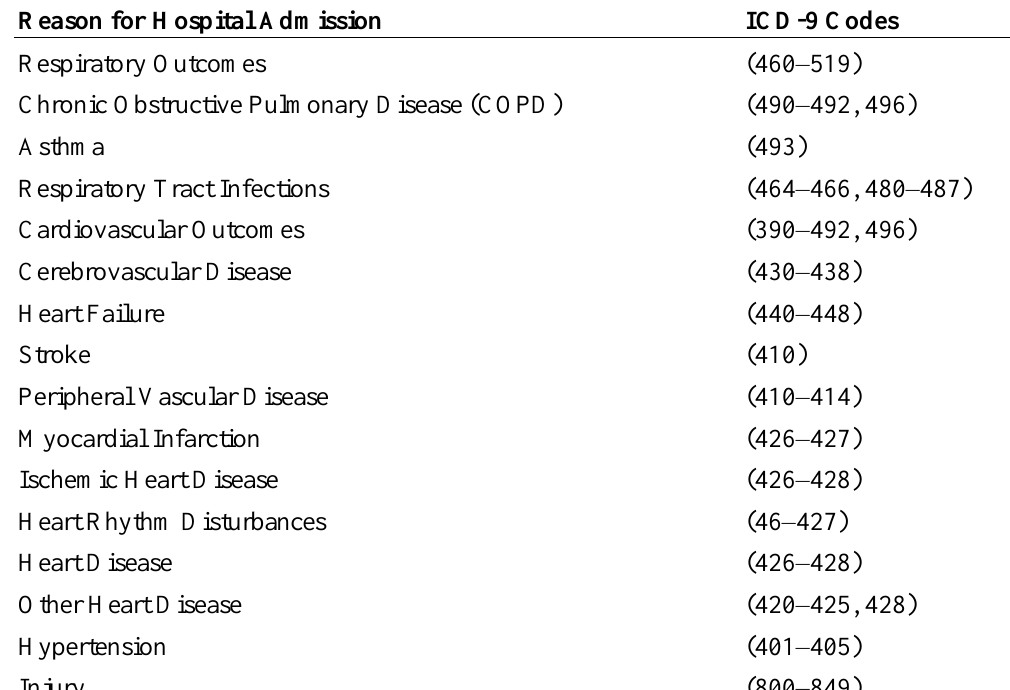
Table 1. Diagnosis